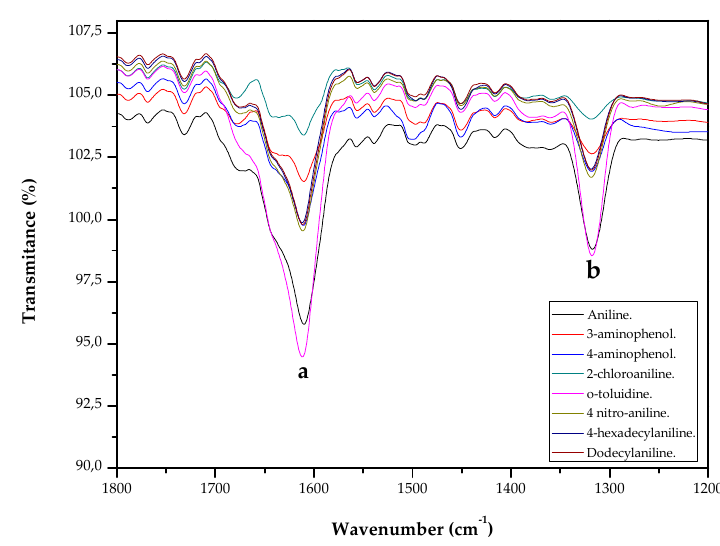
Figure 5. Fourier transform infrared spectroscopy (FTIR) spectra of CaOx crystals grown on sulphonated PS films, and diazotated with aniline, 3-aminophenol, 4-aminophenol, 2-chloroaniline, o-toluidine, 4-nitroaniline, 4-hexadecylaniline and dodecylaniline.